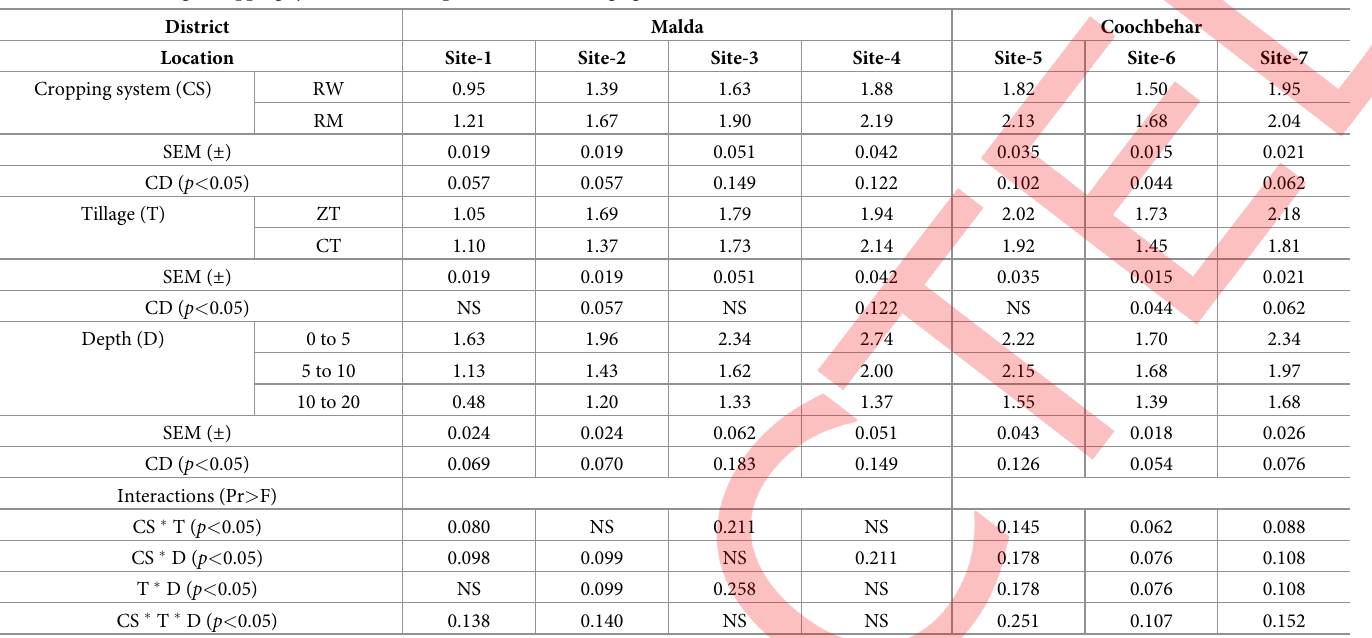
Table 3. Effect of tillage, cropping system, and soil depth on LP1 carbon (g kg -1 ) in different sites of Malda and Coochbehar districts.